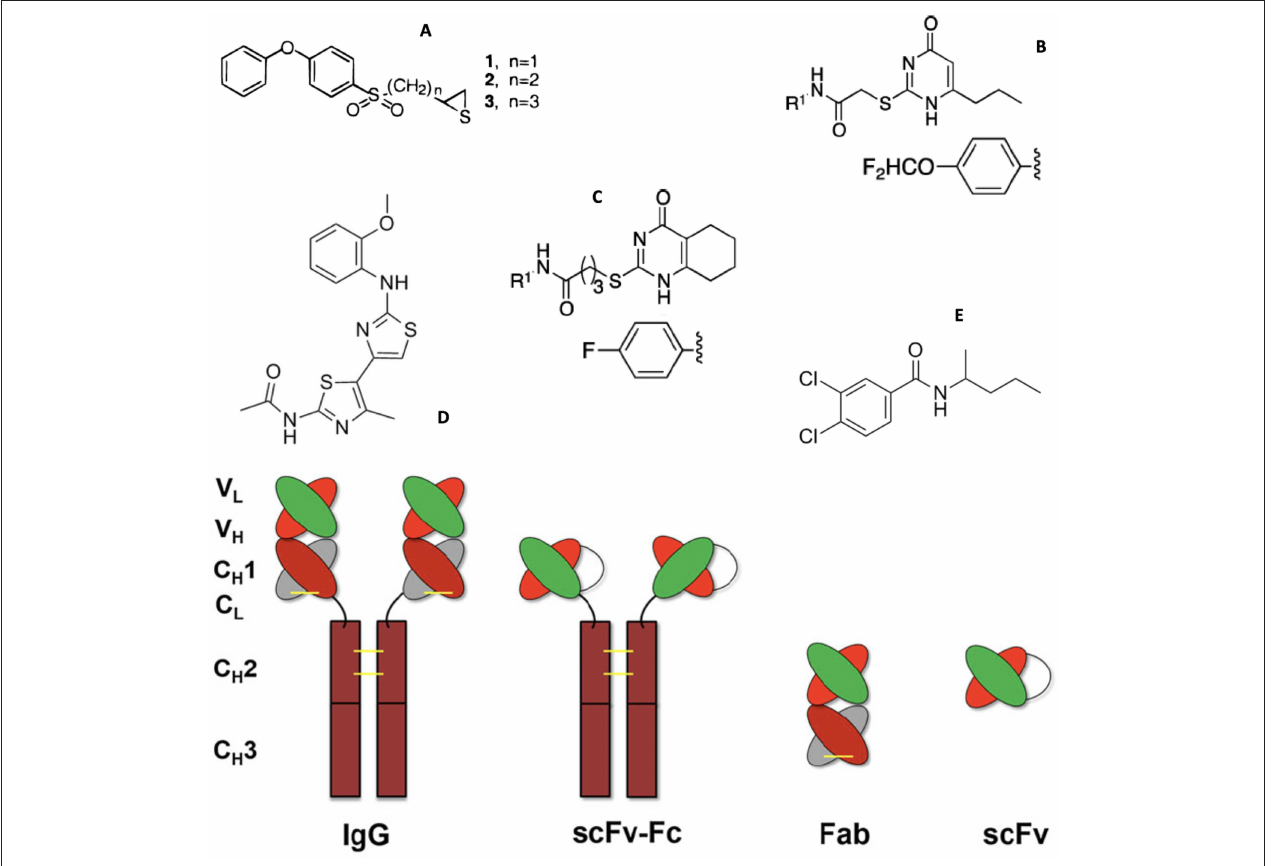
FIGURE 2 | Structures of MMP small molecule inhibitors (A) thiiranes (where n = 1 for SB-3CT), (B) N -[4-(difluoromethoxy)phenyl]-2-[(4-oxo-6-propyl-1 H -pyrimidin-2-yl)sulfanyl]-acetamide, (C) N -(4-fluorophenyl)-4-(4-oxo-3,4,5,6,7,8-hexahydroquinazolin-2-ylthio)butanamide, (D) JNJ0966 [ N -(2-((2-methoxyphenyl) amino)-4 ′ -methyl-[4,5 ′ -bithiazol]-2 ′ -yl)acetamide], and (E) NSC405020 [3,4-dichloro- N -(1-methylbutyl)benzamide], and (bottom) MMP inhibitory antibodies (IgG) and antibody fragments. Illustrations reprinted with permission from Brown et al. ( 28), Alford et al. (29), and Santamaria and de Groot (30). Copyright 2000 and